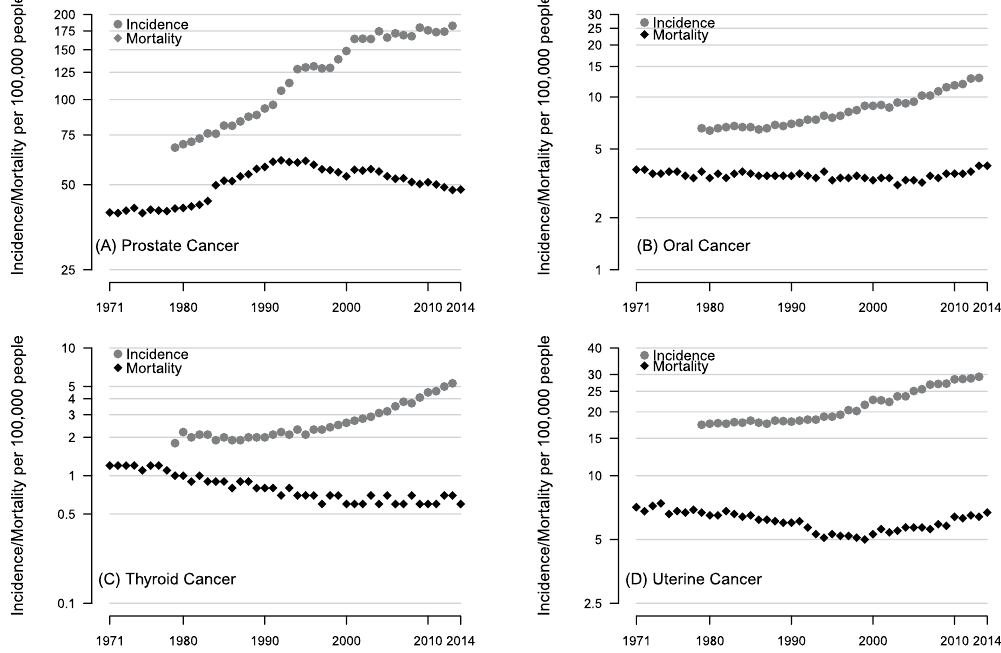
Figure 4. European age-standardised Incidence and cancer-specific mortality (per 100,000) for ( A ) prostate (males only), ( B ) oral (males and females), ( C ) thyroid (males and females) and ( D ) uterine cancer (females only).